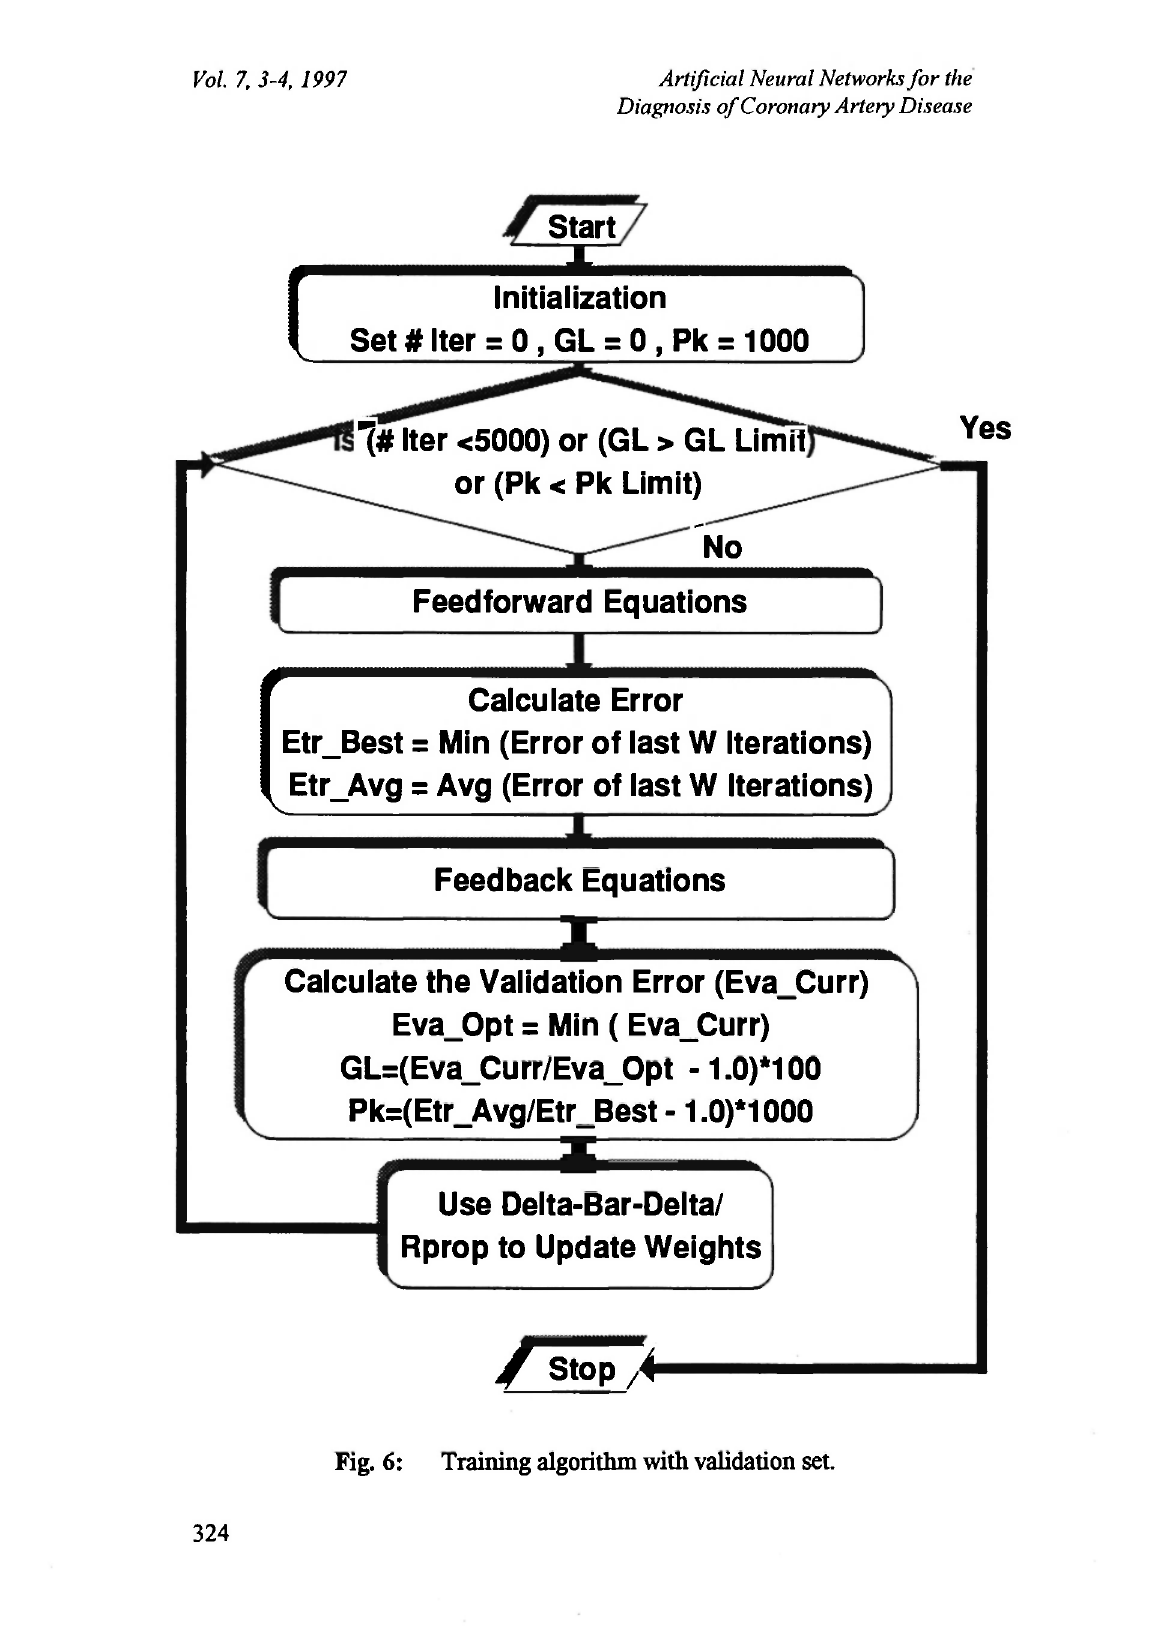
Fig. 6: Training algorithm with validation